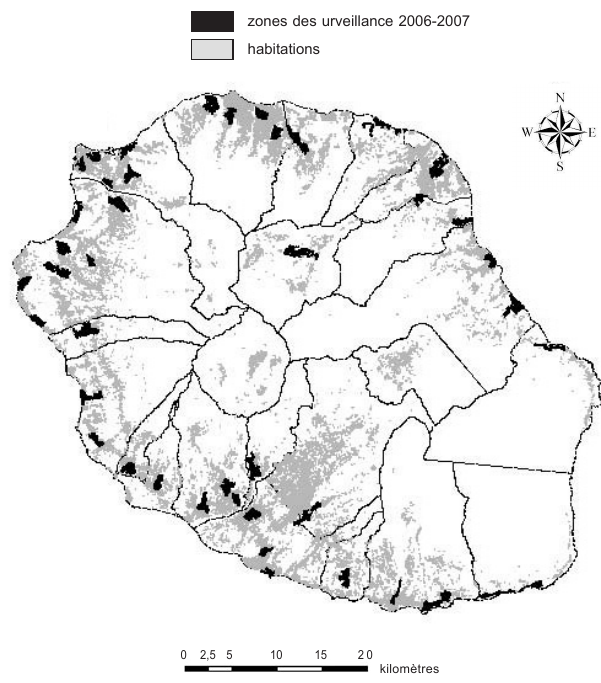
Fig. 5. – Réseau d’entomo-surveillance de